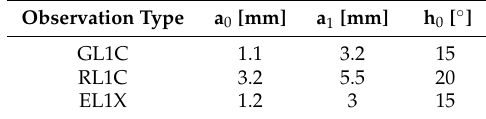
Table 6. Empirical values of the exponential function parameters—JVD Delta